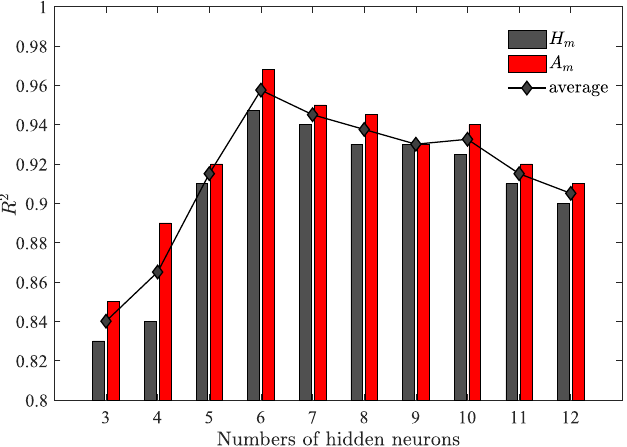
Figure 4. Variation of R 2 versus the number of neurons in the hidden